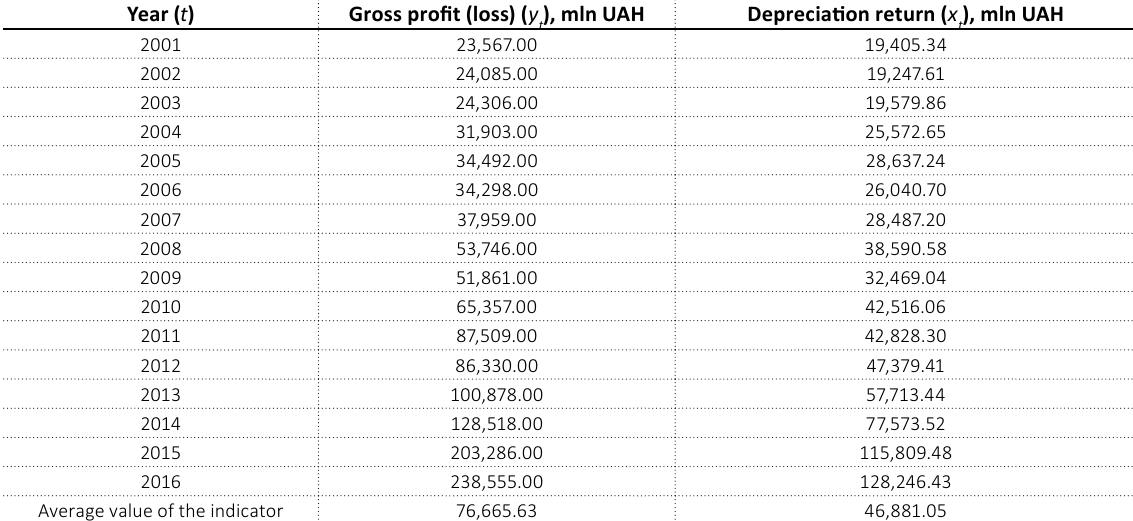
Table 2. Dynamics of gross profit indexes of the investigated industry and depreciation return for